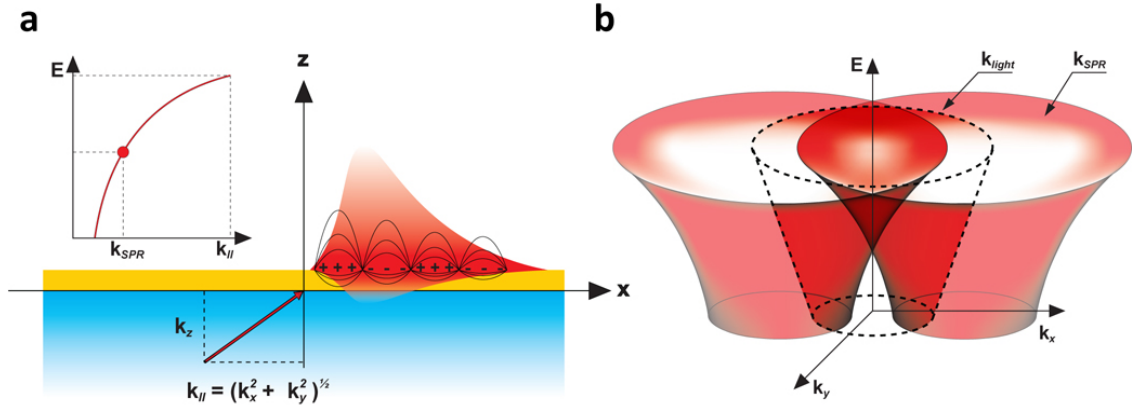
Figure 2. ( a ) Broadband uncollimated induction of SPR. At a given energy, E, and specific wavevector k = k , electromagnetic charge fluctuations in the form of surface plasmons ll SPR can be coupled at a metal-dielectric interface. Changing the input energy will modify the to couple a resonance. As such, there is a continuous dispersion relation E(k required k ll for the resonant coupling of the surface plasmons (inset); ( b ) Since k direction ( (cid:1824)(cid:3548) , (cid:1825)(cid:3548) ) on the surface, the SPR dispersion in the E(k shape surface. Note that under normal circumstances k scattered within the light cone by the surface corrugation, through the ±1st diffraction order of a grating for example, to be measured by a microscope in the far field